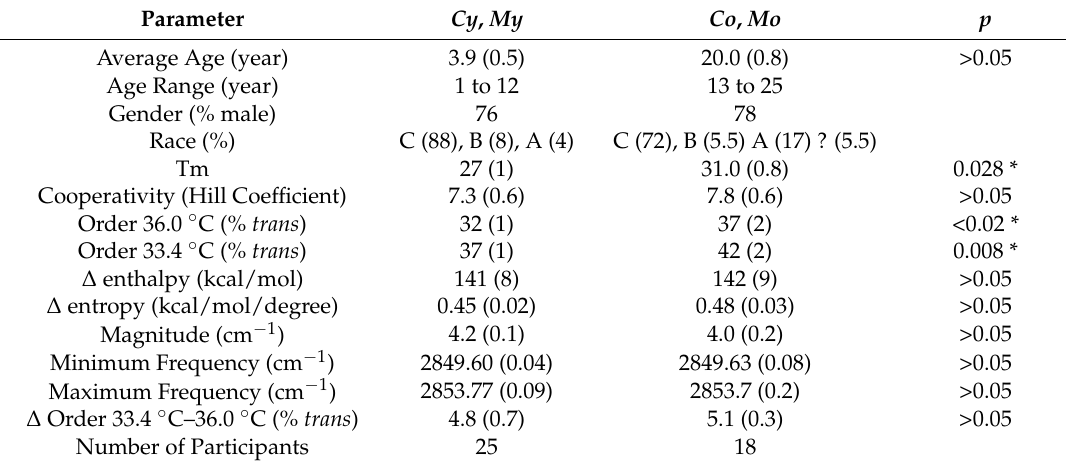
Table 1. Donor demographics and phase transition